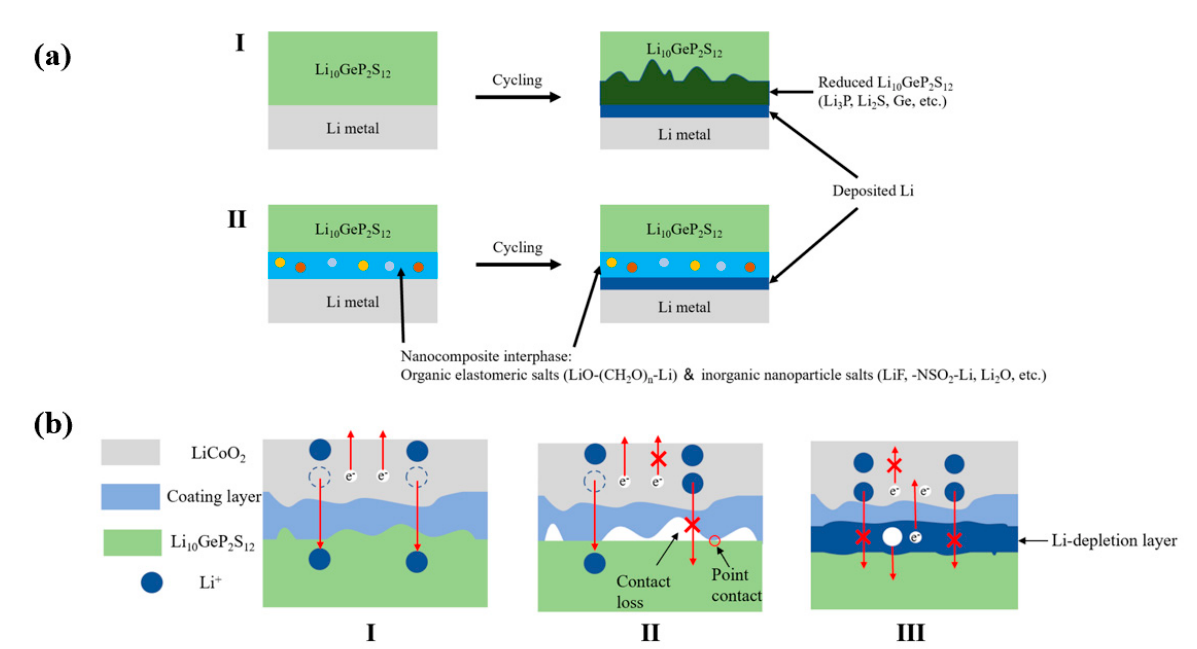
Figure 8. ( a ) Schematic of the Li/LGPS interface with Li salt-based organic-inorganic nanocomposite as an interfacial protective layer. (I) Li and LGPS show poor interfacial stability. LGPS is reduced by metallic Li, and some poorly ionic conductive products (Li 3 P, Li 2 S, Ge, etc.) are formed at the interface. (II) The stability of the Li/LGPS interface is improved by nanocomposite interphase consisting of organic elastomeric Li salts (LiO-(CH 2 O) n -Li) and inorganic nanoparticle salts (LiF, -NSO 2 -Li, Li 2 O). ( b ) Schematic of three possible situations occurring in the interface between LiCoO 2 and LGPS during cycling. (I) Ideal electrode–electrolyte interface. (II) Poor contact between the electrolyte and electrode after cycling. (III) Li depletion layer forms between the electrolyte and electrode.